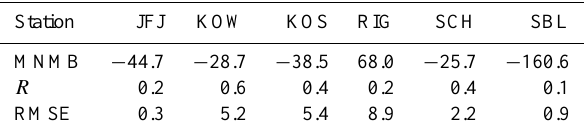
Table 8. Modified normalised mean bias (MNMB) [%], correlation coefficient ( R ), and root mean square error (RMSE) [ppb] derived from the evaluation of the MACC_osuite with Global Atmospheric Watch (GAW) NO 2 surface observations during the period Septem- ber 2009 to December 2012. The conventional station names are listed in Table